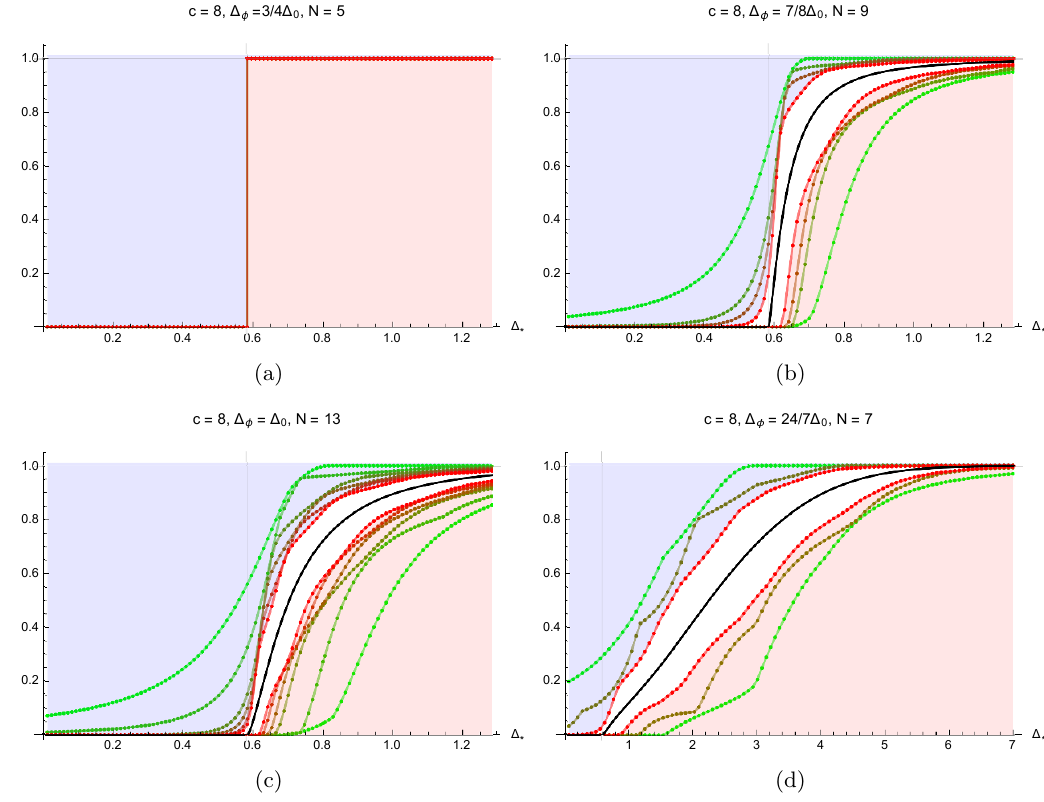
Figure 1 . Upper and lower bounds on the spectral function from linear functionals of in- creasing derivative order (from green to red), assuming only scalar primaries for c = 8 with (cid:1) (cid:30) = (cid:1) 0 = 3 ; 7 ; 1 ; 24 . In all cases, the shaded regions are excluded and the black curve denotes 4 8 7 the corresponding spectral function of (analytically continued) Liouville